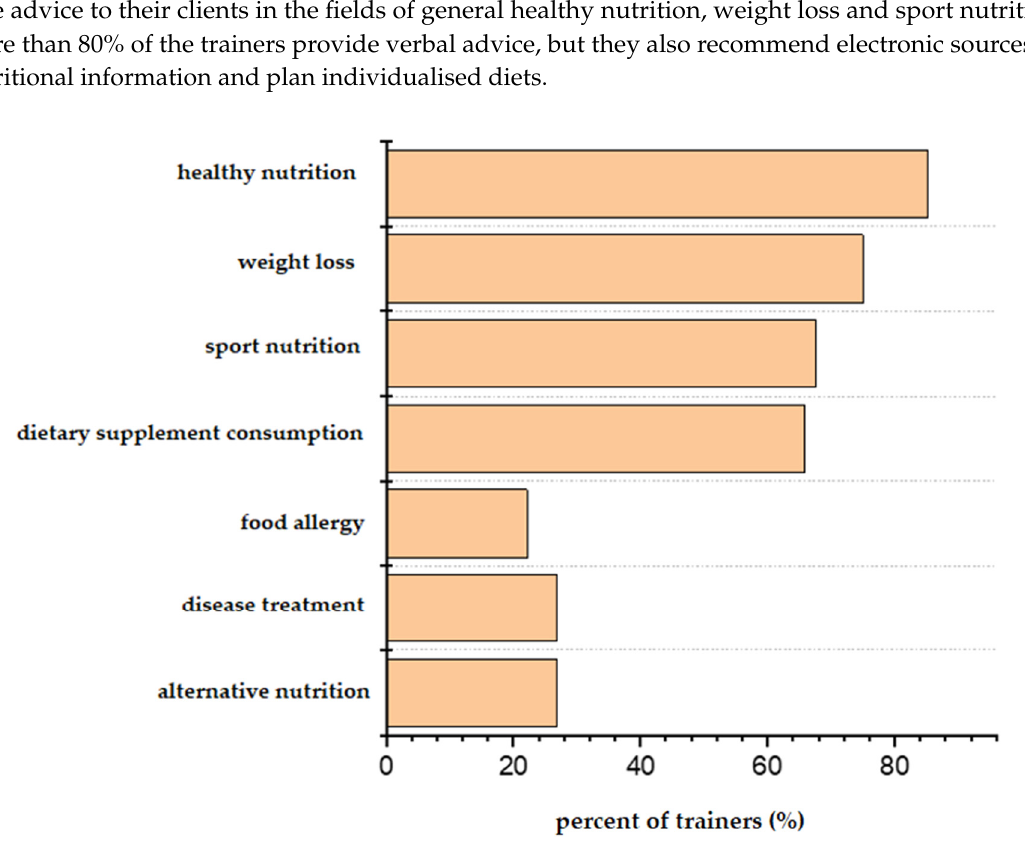
Figure 5. Form of nutrition related advisory activity. The intensity of the nutrition-related activity of trainers has been evaluated based on a 1–10 scale depending on a portfolio of their nutrition-counselling activities and the channels of communication. The shelf-reported contents of communication (applying now closed-ended questions) were as follows: •